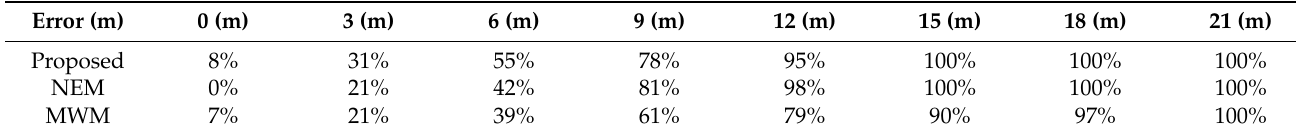
Table 13. KNN with NEM Simulated Test Samples.